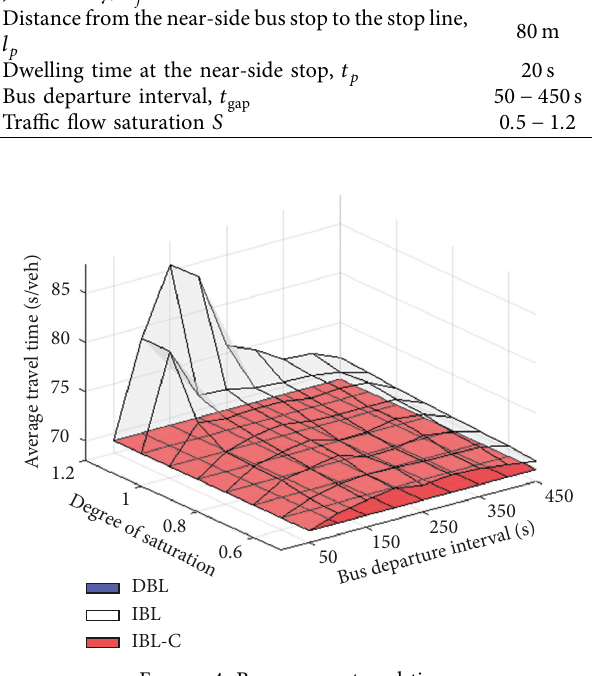
Figure 4: Bus average travel time.